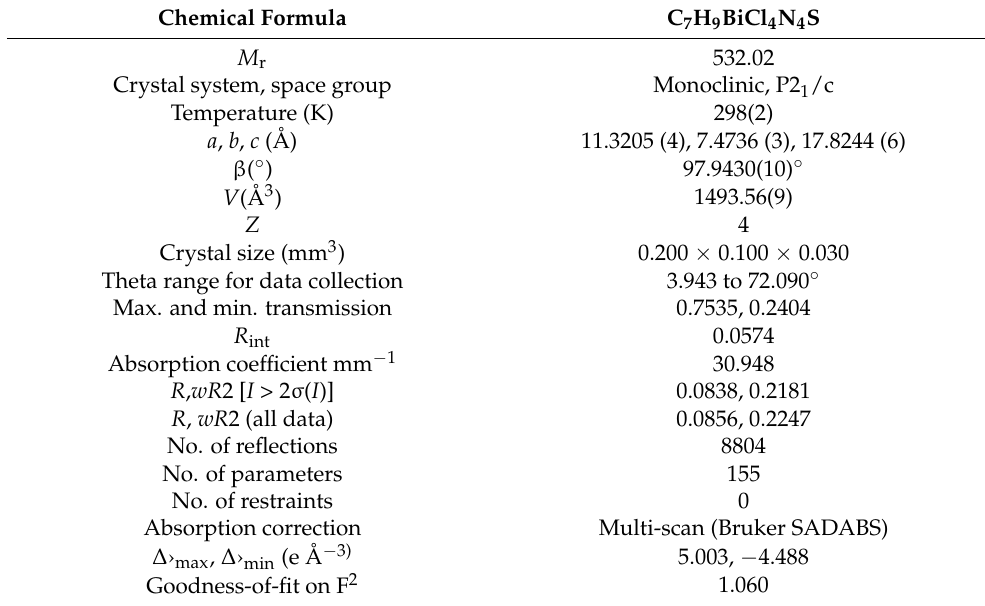
Table 1. Coordination compounds crystallographic data and structural refinements.